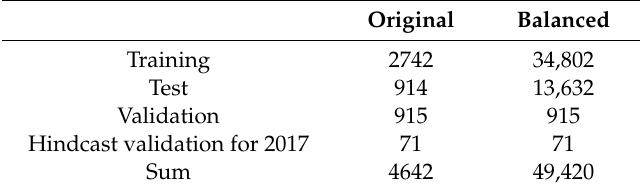
Figure 2. Overview of subsampling and oversampling processes for balancing tropical cyclone samples. Table 2. The number of samples before and after data balancing processes.